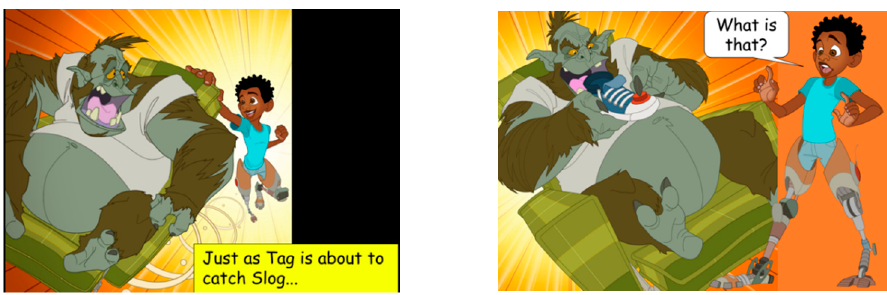
Figure 2. Two sequential slides of a FIT Game episode. The FIT hero, Tag, is about to capture a villain, Slog, in the first slide, but in the second, Slog uses a sneaker-shaped transporter device. Reprinted with permission from Utah State University. Copyright 2017 Utah State University.